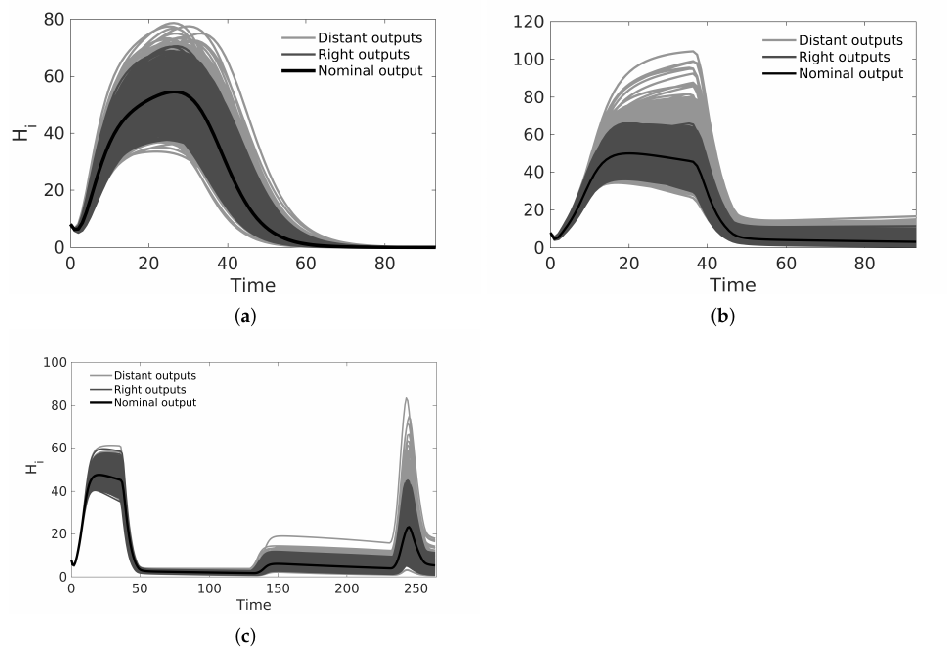
Figure 2. Uncertainty analysis for the dengue model in cases A, B, and C using CSB intervals from Table 2 with 1000 simulations. The CSB method guarantees that at least 95% of curves generated from random combinations of parameters produce outputs classified as ‘right’ outputs. ( a ) Uncertainty analysis for dengue model with non pulses input; ( b ) uncertainty analysis for dengue model with one pulse input; ( c ) uncertainty analysis for a dengue model with four pulse